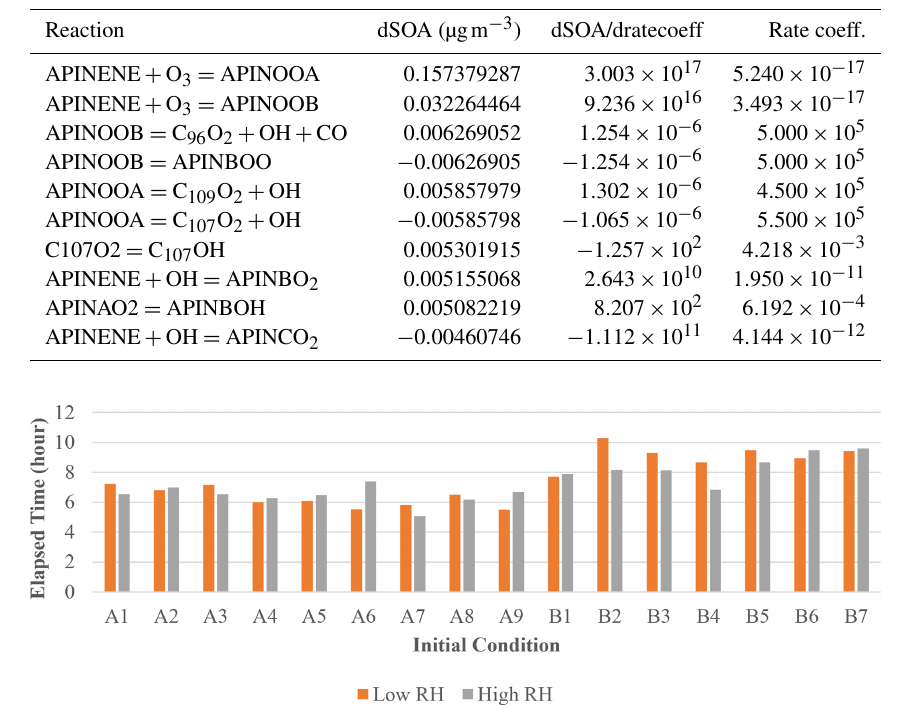
Figure 4. Elapsed time of 72h mixed-phase simulations. The initial conditions used for each case are listed in Appendix A.